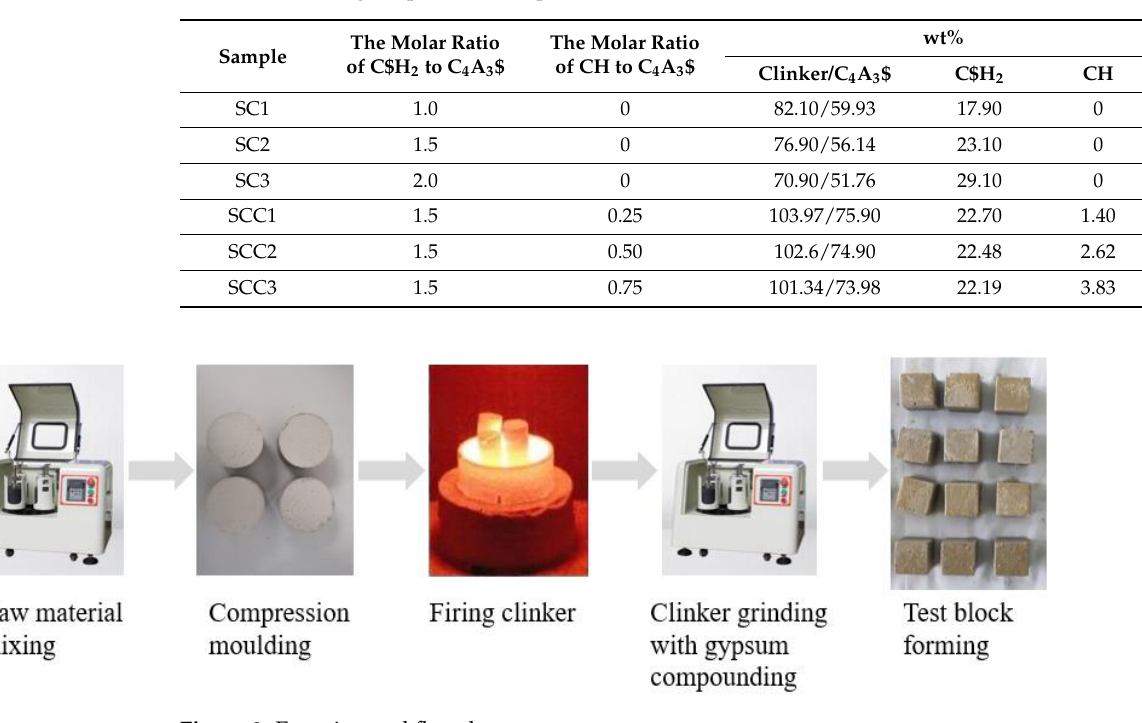
Figure 2. SEM-SE morphology of cement clinkers. Table 4. Mineralogical phase in samples SC1-SC3 and SCC1-SCC3.